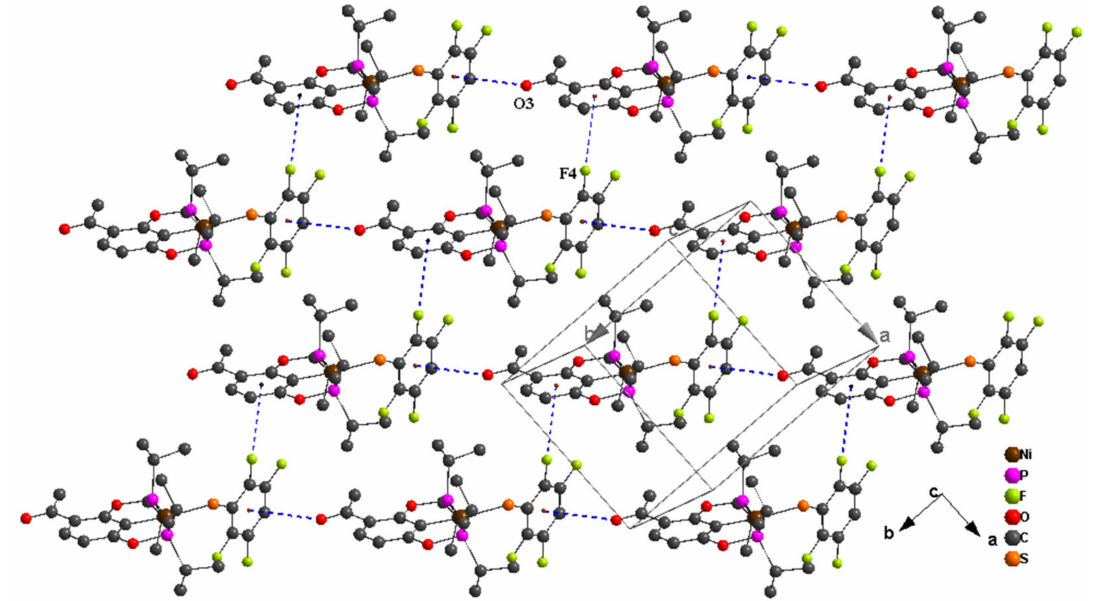
Figure 4. The molecular packing of compound ( 2 ) showing the formation of C7=O3 ··· Cg(C21–C26) and F4 ··· Cg(C1–26) interactions parallel to the (110) plane. The hydrogen atoms are omitted.